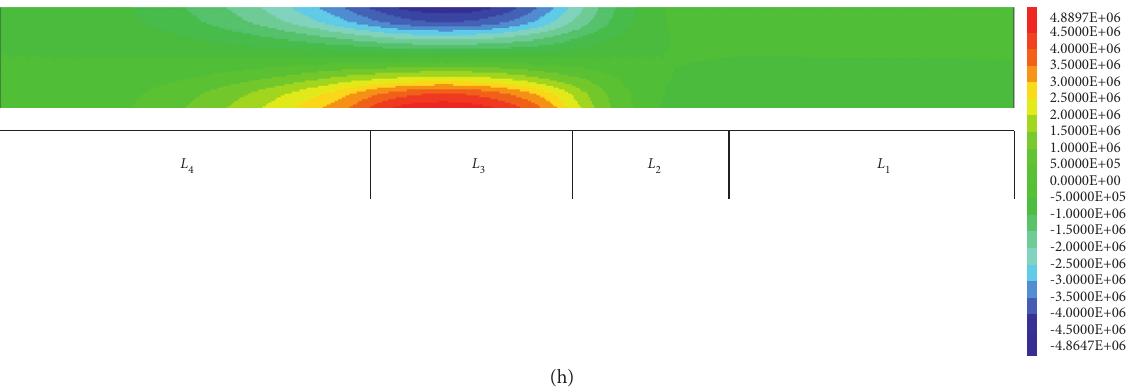
Figure 10: Immediate roof horizontal stress distribution cloud map of the retained roadway with different lengths of the lagging un- supported roof (unit: Pa). (a) 2.5 m. (b) 3.0 m. (c) 3.5m. (d) 4.0m. (e) 4.5m. (f) 5.0m. (g) 6.0m. (h)